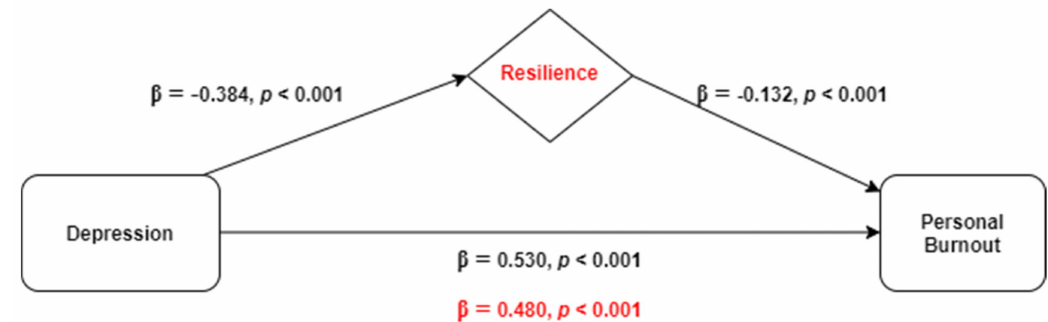
Figure 1. Representative scheme of the mediating role of resilience in the relationship between depression and personal burnout. Changes in beta weights when the mediator is present are highlighted in red.